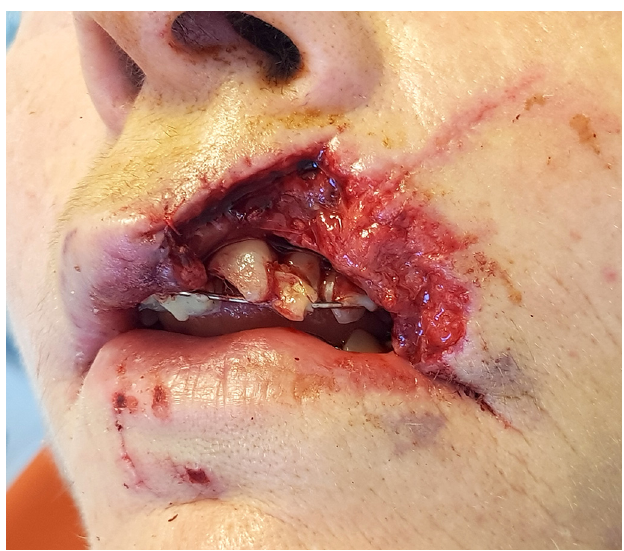
Fig. 2. At day 5, aspect of the lesion after resection of the sutured lip portion.